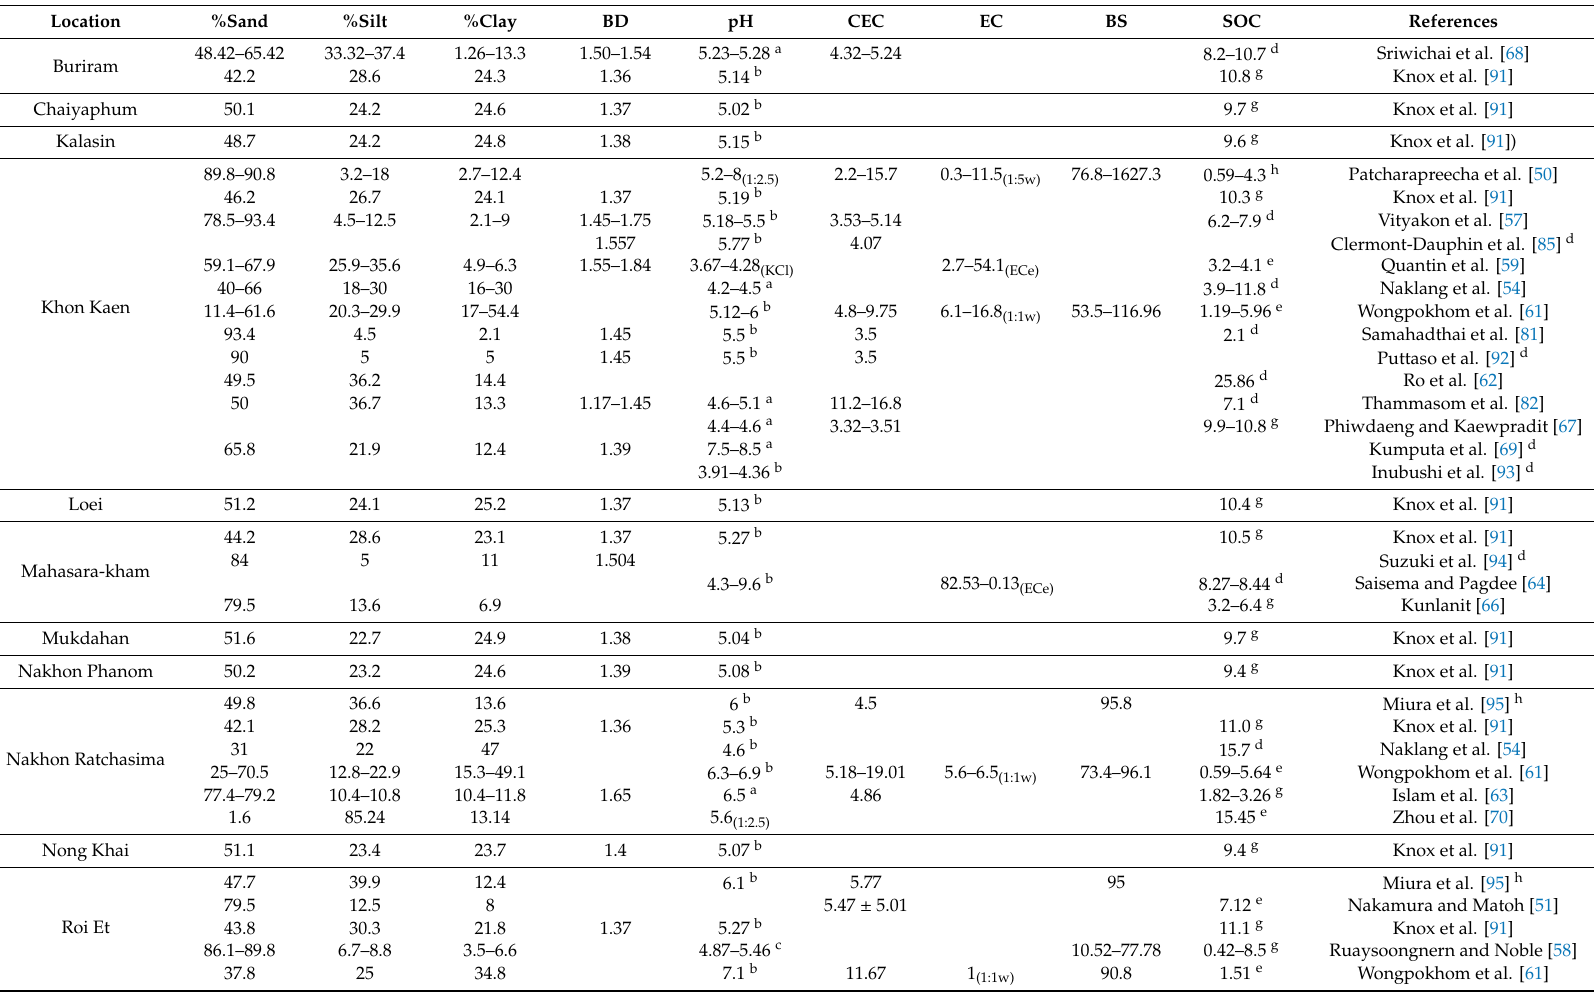
Table 1. Overview on physicochemical characteristics of sandy soil in Northeast Thailand (within the range of 0–40 cm depth).